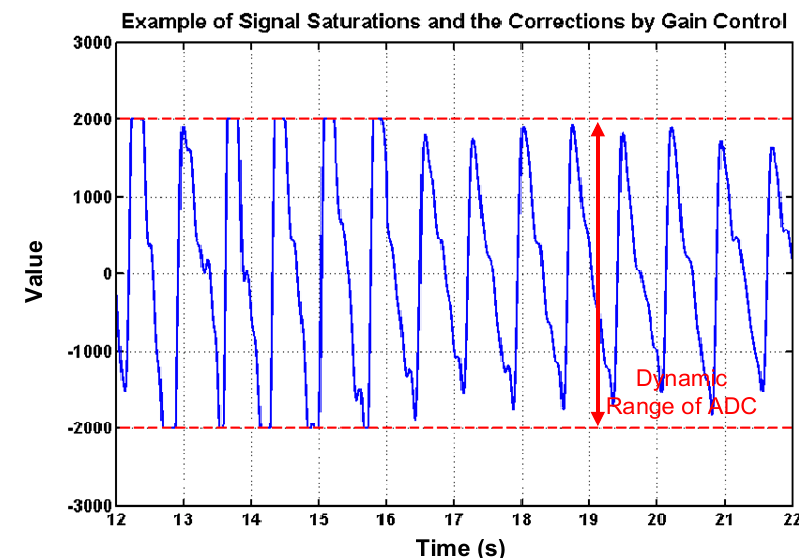
Figure 7. PPG signal saturations and the corrections by using gain control, where it can also be seen that the amplitudes are controlled to full dynamic range of analog-digital converter (ADC) to increase the signal-noise ratio (SNR).